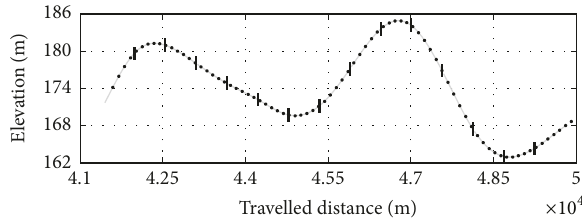
Figure 1: Comparison between the fitted B´ezier splines and the original data, over a part of the road segment between G¨oteborg and Bor˚as. The dots represent the original data and the gray curve represents the fitted splines. The vertical line segments separate